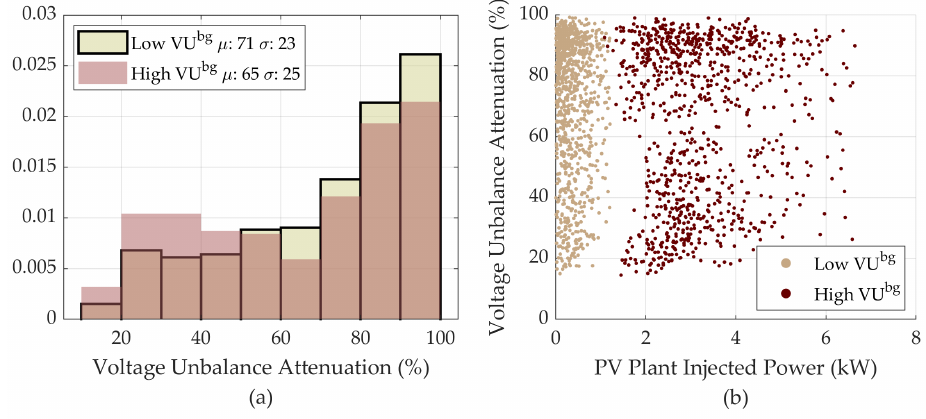
Figure 10. Voltage unbalance attenuation with optimal phase ( a ) and corresponding PV injection ( b ) at the lowest and highest background